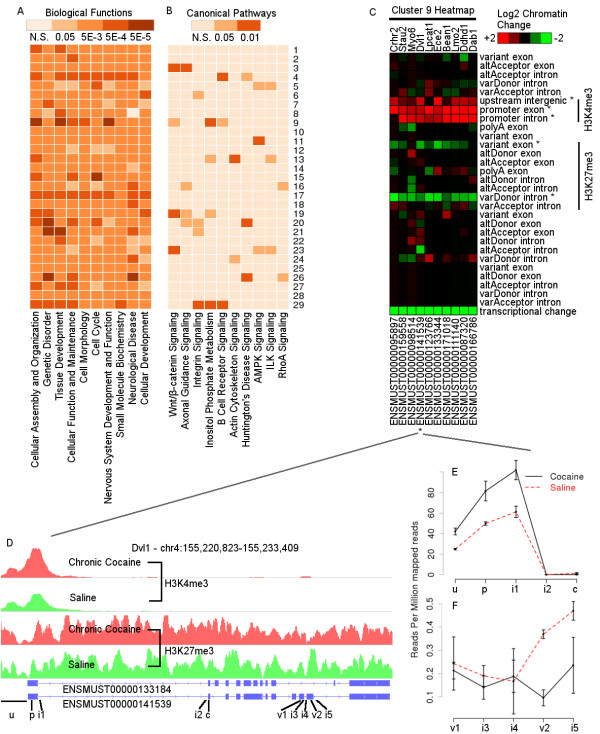
The functional enrichment of the 29 signature clusters and identification of significant chromatin modification regions for an example cluster. (A,B) Each row represents a cluster and each column represents a functional term or canonical pathway. The color of each square represents the statistical significance of enrichment. The enriched terms are ranked by co-occurrence and only the top 10 are shown. (A) Biological functions. (B) Canonical pathways. N.S., not significant. (C) The chromatin modification heatmap for cluster 9. Each column represents a transcript and each row represents a chromatin mark at a specific genomic region. Only 10 example transcripts are shown here. Each square represents the chromatin change in log2 scale. The transcriptional change is simply indicated as a binary value. The significantly modified regions are marked by asterisks to the right of their names. An example transcript, ENSMUST00000141539 of gene Dvl1 (a protein in the WNT/β-catenin pathway), is further illustrated in (D-F). (D) Genome browser screenshot for the demo transcript with H3K4me3 and H3K27me3 in the top and bottom two tracks, respectively. The exon structures of the demo transcript and another transcript of the same gene are shown below the chromatin tracks. The genomic regions are marked by letters ('u', upstream intergenic; 'p', promoter exon; 'c', canonical exon; 'v', variant exon; 'i', intron), and are further followed by numbers to distinguish different regions. (E,F) Mean and standard error of the mean of the significant regions with some neighbors are shown as line plots with error bars. The x-axis represents different regions from 5’ to 3’ and the y-axis represents normalized coverage. (E) H3K4me3 at u, p, i1, i2 and c. (F) H3K27me3 at v1, i3, i4, v2 and i5.